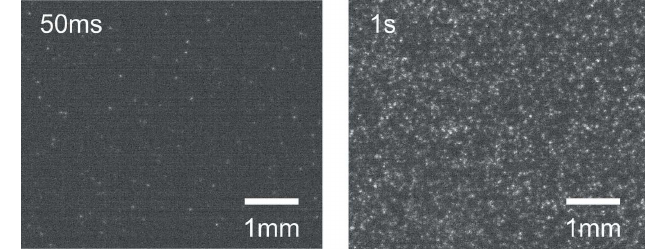
Figure 12 Unprocessed images acquired with a tungsten target (the energy range is 58–69 keV) at two exposure times. The scintillator is an 11 m m GOS:Tb screen and the pixel size is 6.5 m m.